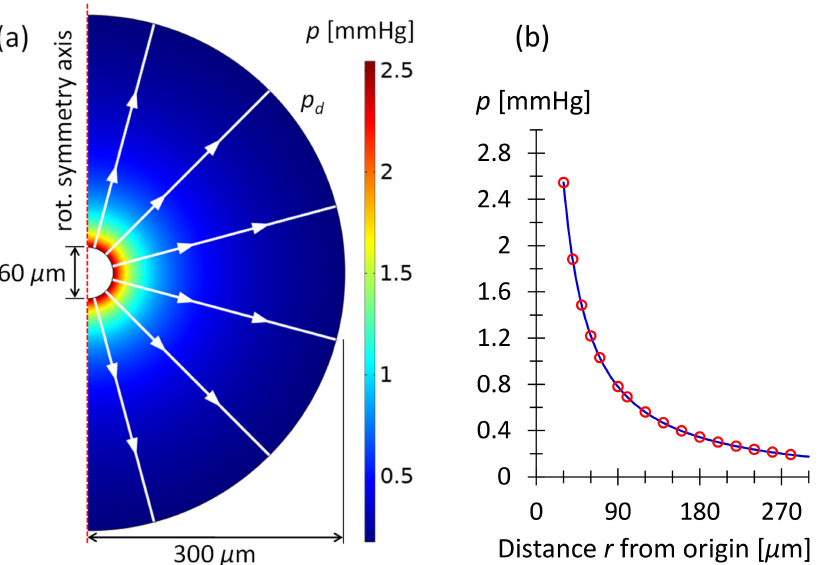
Figure 5. ( a ) COMSOL simulation of the outflow from a bleb with radius r b = 30 µ m. The inlet . . M = Q b · (cid:36) = 3.3 × 10 − 11 kg boundary condition is the mass flow rate at the hemispherical bleb s . . Q b = Q t = 2.0 nL surface. This corresponds to , given in Table 2. The outer boundary condition is min the pressure p d = 0.17 mm Hg at the domain boundary at r d = 300 µ m. p d is calculated by means of Equations (8) and (11) and used to mimic an infinite domain. The white lines and arrows indicate the flow direction given by the simulation. The axis of rotational symmetry is shown as a vertical, dashed red line. ( b ) Pressure as a function of distance from the origin. The blue line is the COMSOL result; the red circles are obtained using Equations (8) and